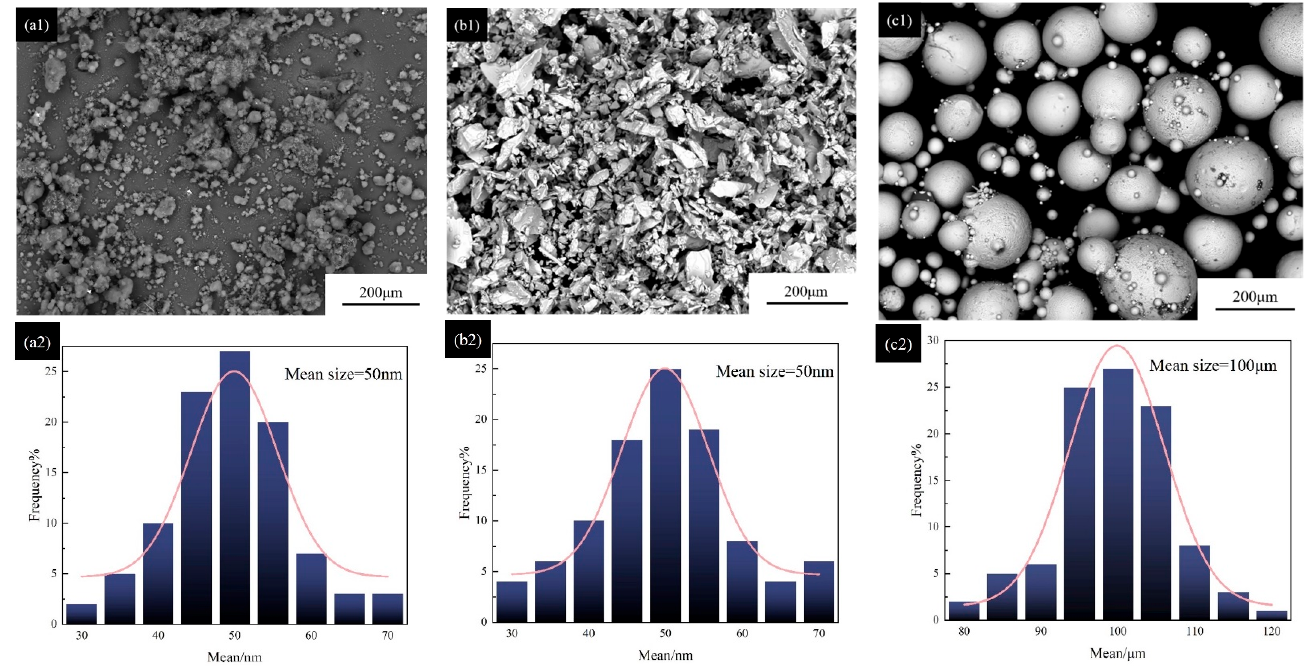
Table 1. Chemical composition of Ni45 (wt%).